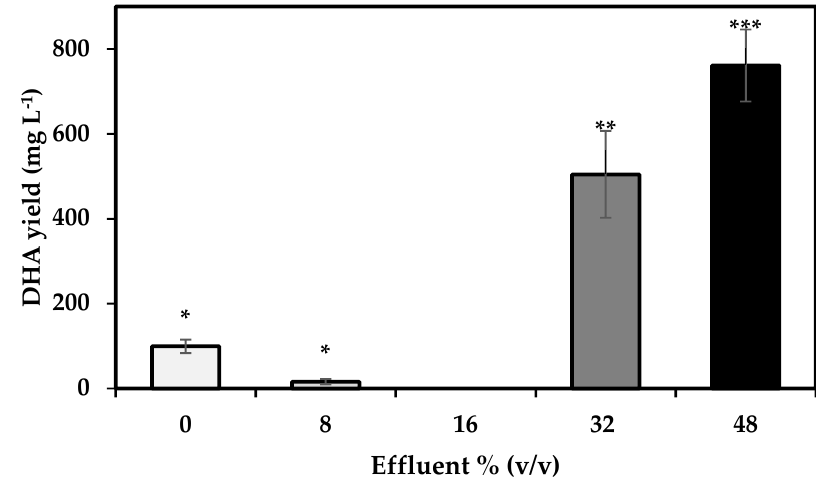
Figure 4. DHA yield of S. limacinum grown on medium containing effluent digestate at varying concentrations (0–48%) with the same carbon and nitrogen concentration without the addition of micronutrients. Values are represented as mean ± standard deviation of triplicates, whereas asterisks indicate statistical differences analyzed at a level of p < 0.05.